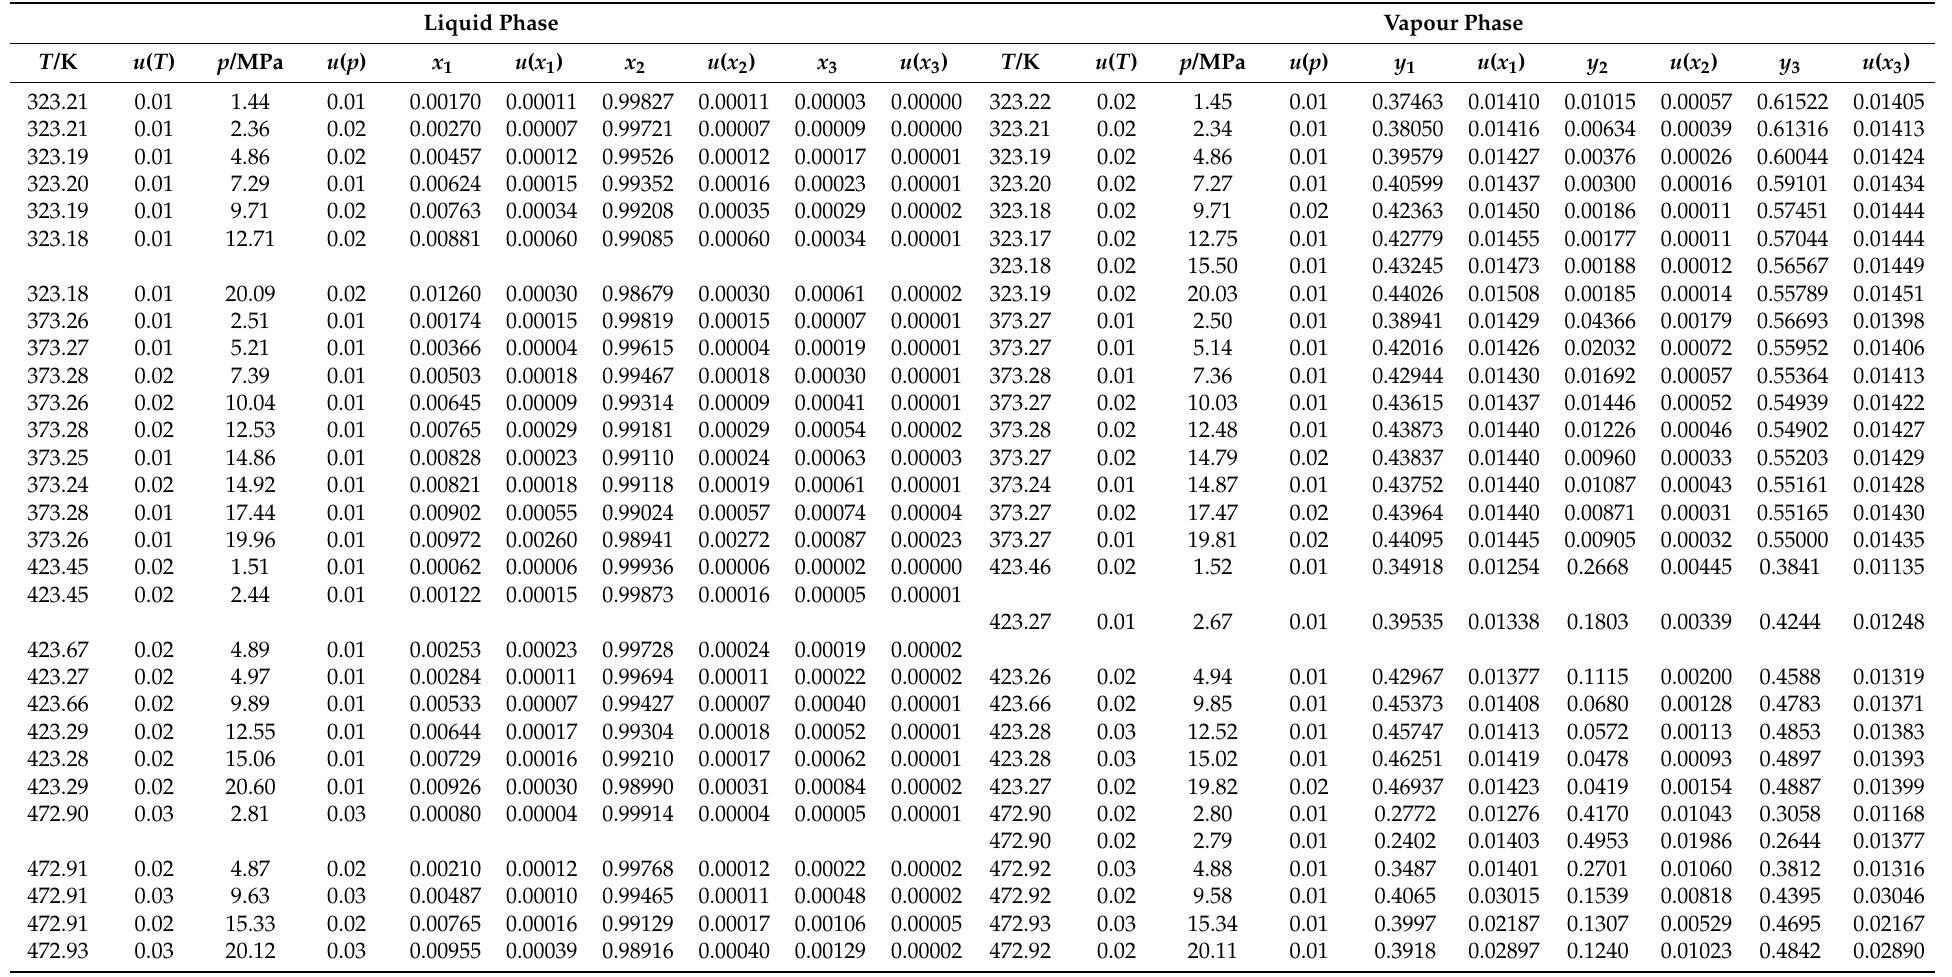
Table 9. Experimental vapour–liquid equilibrium data for the [CO 2 (1) + H 2 O(2) + N 2 (3)] system at different temperatures, T , and pressures, p . x and y denote the mole fraction in the liquid and vapour phase, respectively. u is the standard